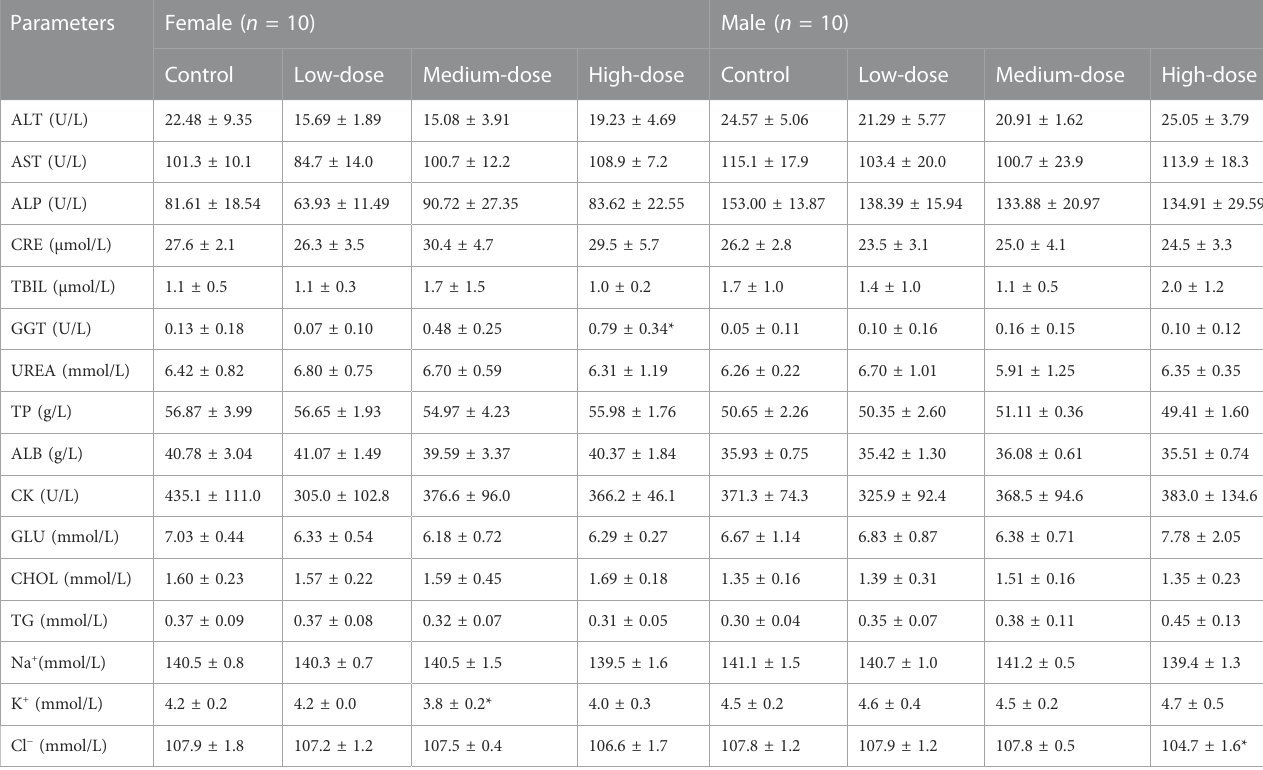
TABLE 4 Biochemical parameters of rats after 28 days of administration with GCXXD. Parameters